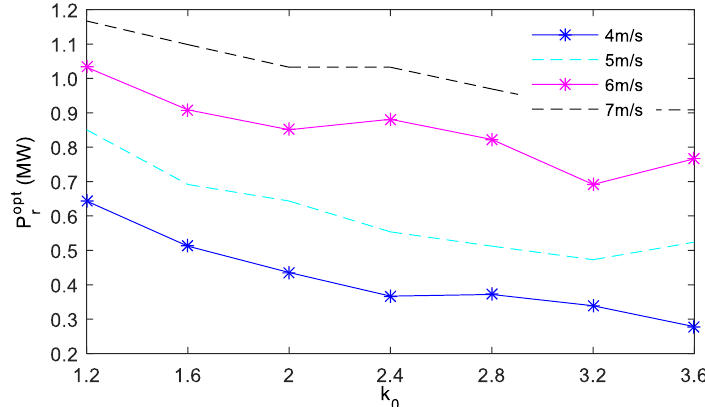
v and k . Figure 5. The optimal capacity of offshore turbines versus v m and k 0 m 0